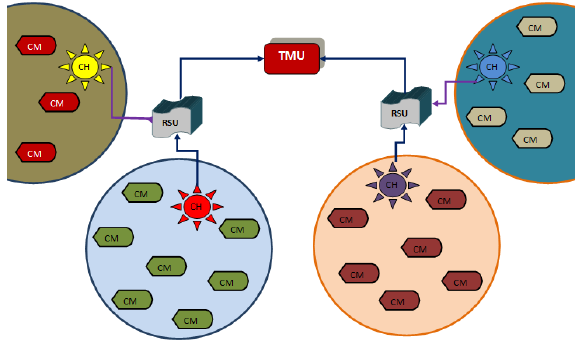
Figure 2. TACRP Network Architecture.